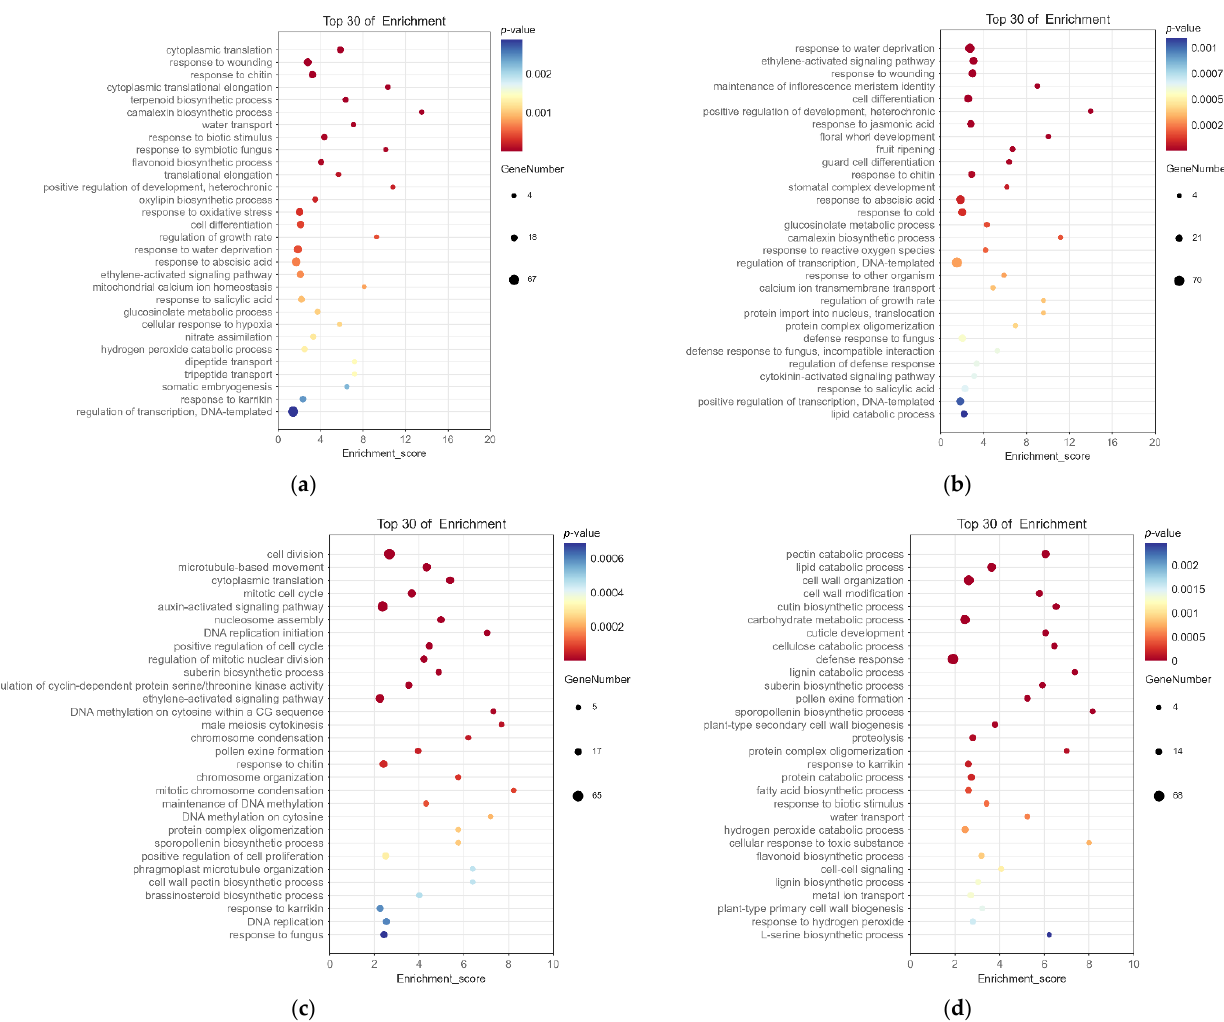
Figure 5. Bubble diagram of the top 30 biological process terms enriched in GO. The horizontal axis in the figure represents the enrichment score, and the vertical axis represents the terms name. The terms with larger bubbles contain a higher number of differential protein-coding genes. The bubble color changes from blue to red, and the smaller the enrichment p -value, the greater the significance. ( a ) BS1 vs. BS2. ( b ) BS2 vs. BS3. ( c ) BS3 vs. BS4. ( d ) BS4 vs. BS5.